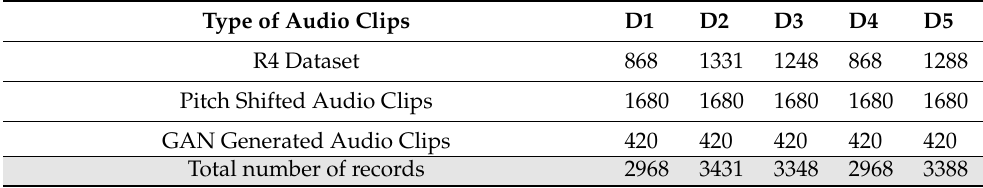
Table 6. Breakdown of RGA